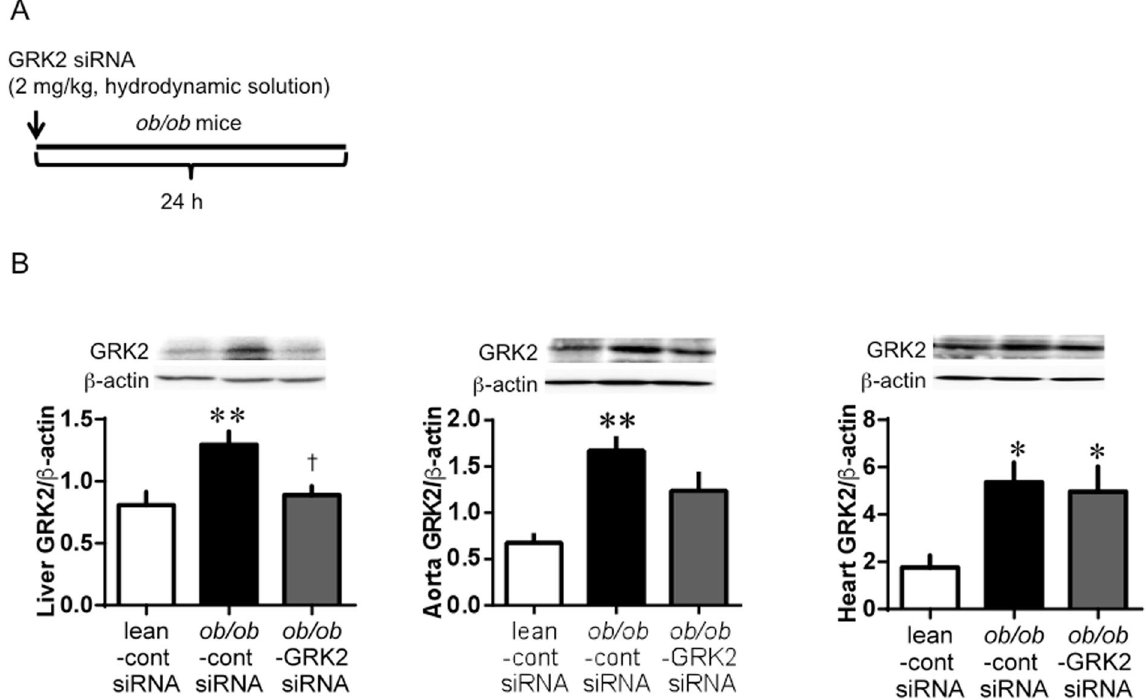
Figure 1. GRK2 is reduced by GRK2 siRNA delivery in liver. ( A ) Experimental protocol for ob/ob mice: ob/ob mice or lean (control) mice were treated with GRK2 siRNA or control siRNA by hydrodynamic delivery as indicated (intravenously, 2 mg/kg). ( B ) Western blot analysis of GRK2 in the liver, aorta and heart, respectively. Top is the representative Western blots for GRK2 protein, and bottom is the total GRK2 expression. Ratios were calculated for the optical density of GRK2 over that of β -actin. Values are mean ± SE; n = 6. * p < 0.05, ** p < 0.01 vs. control siRNA-transfected lean mice (lean-cont siRNA); † p < 0.05 vs. control siRNA-transfected ob/ob mice ( ob/ob -cont siRNA) by one-way analysis of